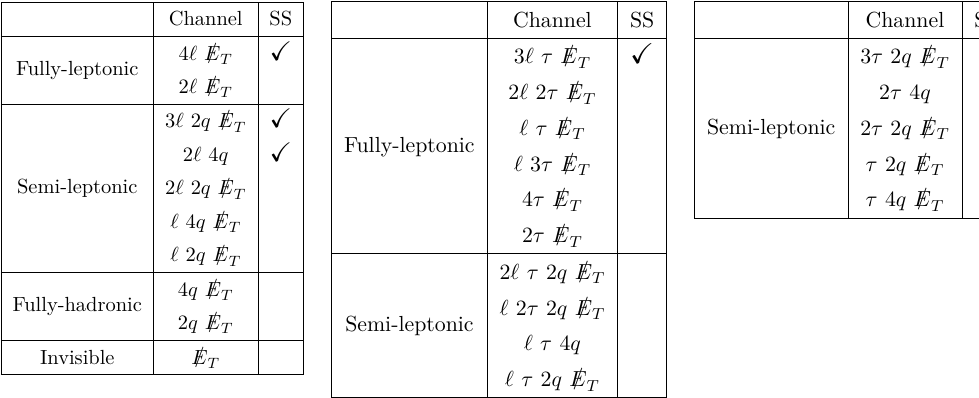
Table 2 . Possible final states from the decay of pair produced RH neutrinos. The checkmarks correspond to channels that can produce a SS leptons signal. The leftmost and rightmost tables contains final states without τ leptons and light leptons, ‘ ,